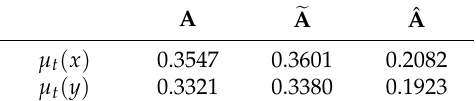
Table 1. t -Averaged mutual coherence.